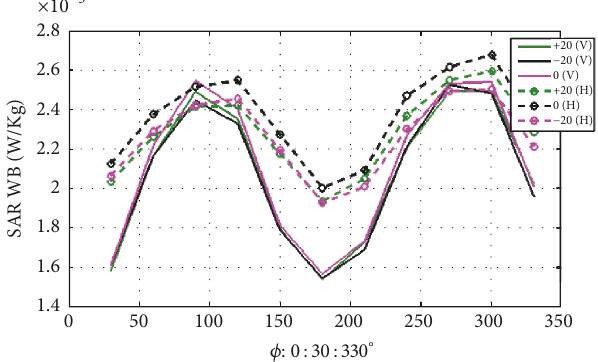
Figure 12: Variation of SAR obtained with the posture data- WB standing-1940 MHz after an exposure to a plane wave coming from three elevations, from azimuth from 0 to 360 and in both V- polarization and H-polarization.